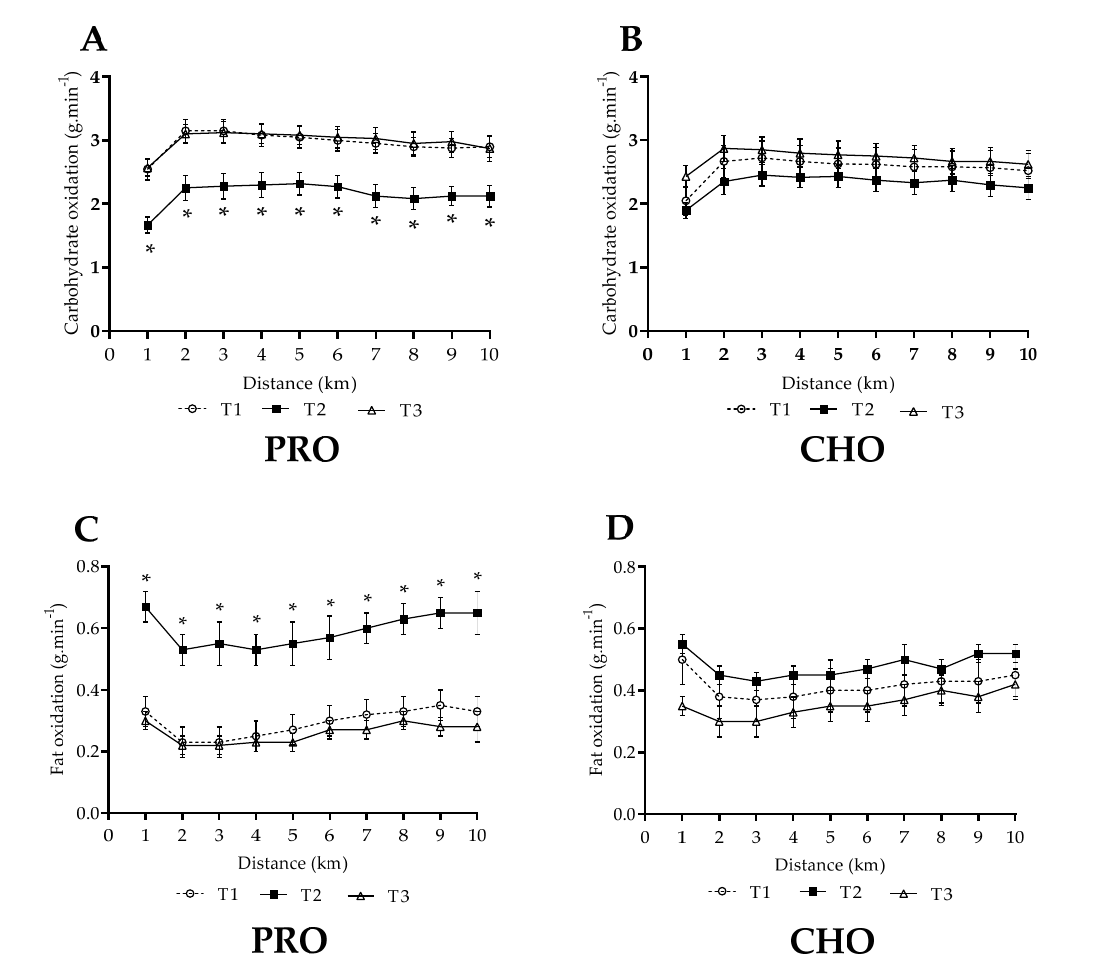
Figure 2. Substrate oxidation rates (g.min − 1 ) during a 10-km steady state (~75% VO 2max ) treadmill run following habitual and intervention diet phases. Habitual dietary intake in first (T1) and third (T3) week. Intervention phase (T2) consisting of either high protein (PRO) or high carbohydrate (CHO) intake. Carbohydrate oxidation (g · min − 1 ) in PRO ( A ), carbohydrate oxidation in CHO ( B ), fat oxidation in PRO ( C ) and fat oxidation in CHO ( D ). * Denotes significant difference compared to both T1 and T3 ( p < 0.05).